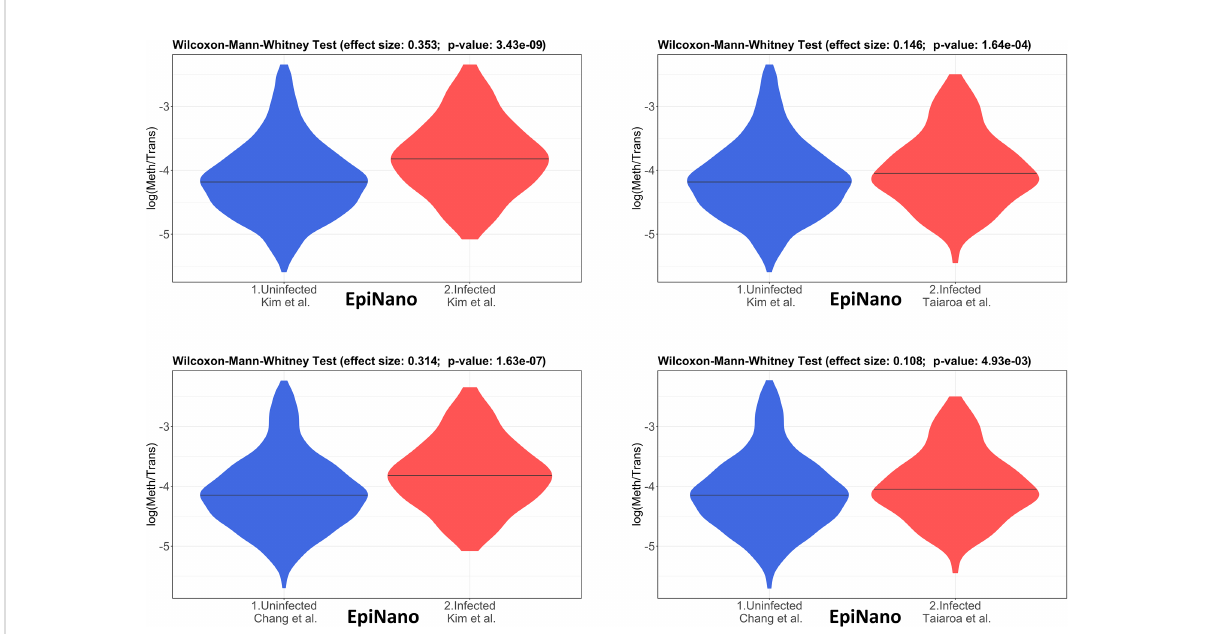
TABLE 5 Results of the Wilcoxon-Mann-Whitney test (WMW) for comparison of differentially methylated transcripts between Uninfected (U) and Infected (I) Vero cell datasets using programs m6anet and EpiNano as indicated. Comparison (WMW) # Transcripts Effect Size Con fi dence (95%) p -value